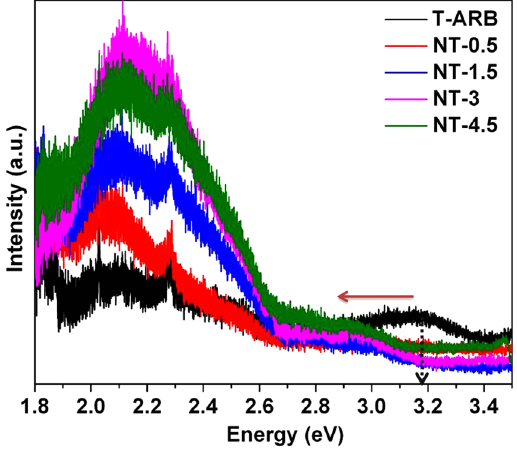
Figure 10. PL emission intensity of pristine and N-TiO 2